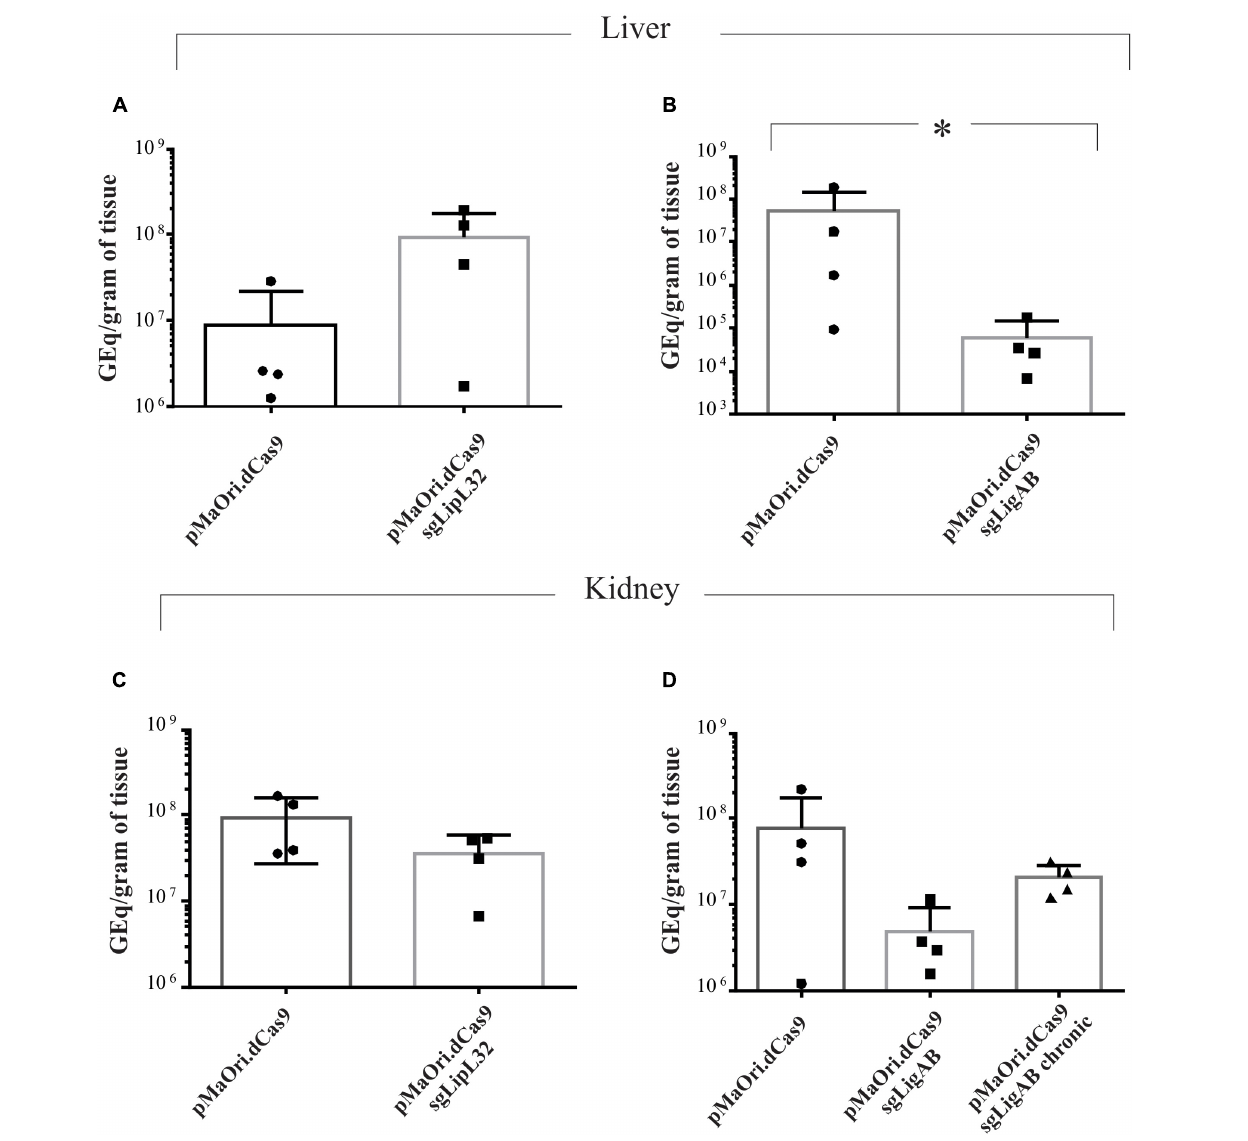
FIGURE 5 | Bacterial burden quantification in target organs from infected animals. Total DNA from liver (A,B) and kidney (C,D) tissue from time-synchronized euthanized animals were used as template for qPCR amplification targeting the lipL 32 gene. The bacterial burden from animals infected with each mutant (LipL32, containing the plasmid pMaOri.dCas9sgLipL32, and LigAB, pMaOri.dCas9sgLigAB) were compared with the control in which animals were infected with leptospires containing empty pMaOri.dCas9. The number of genome equivalents (GEq) were estimated based on a concentration curve run in parallel to the experiment. Additionally depicted in panel (D) is the quantification in kidneys from chronically LigAB mutant infected animals. (*) denotes p -values ≤